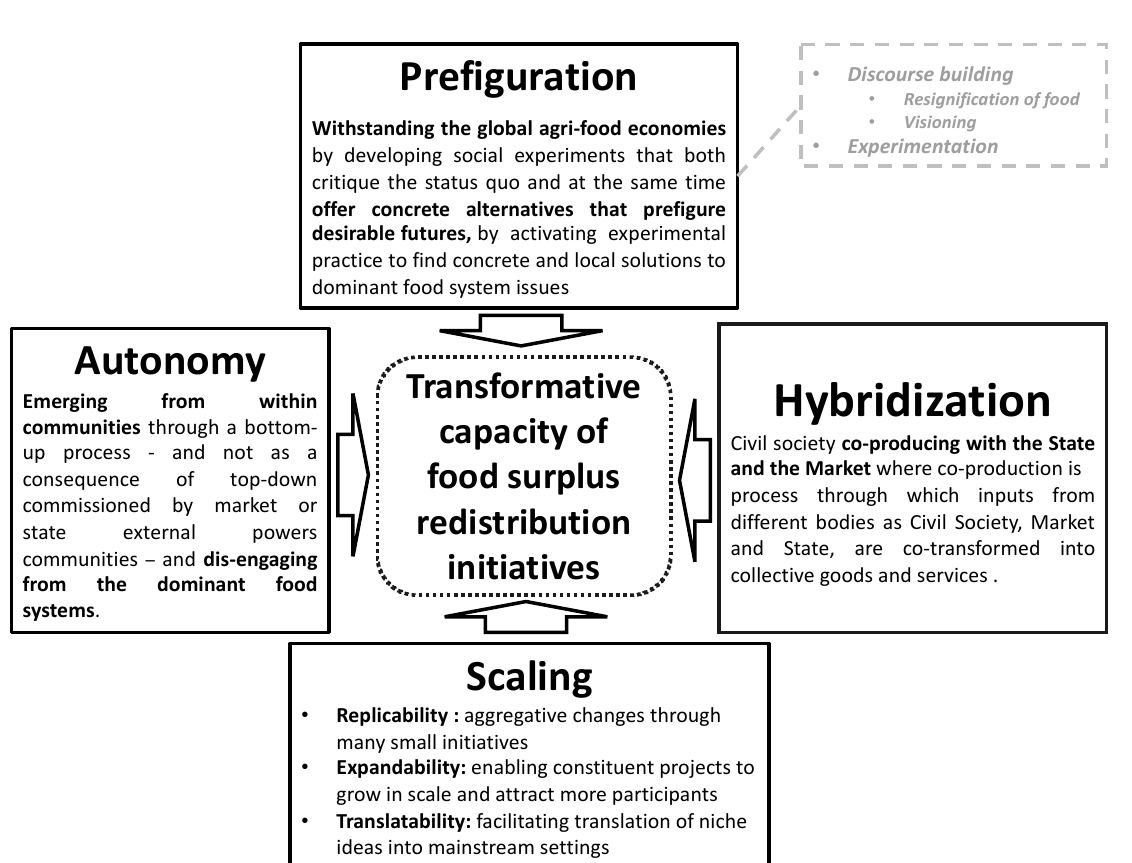
Figure 1. PAHS (prefiguration, autonomy, hybridization, and scalability) conceptual model. Prefiguration. Wilson [59] conceptualises autonomous food spaces as spaces of imagi- nation and experimentation. The combination of these two concepts represents at best the notion of prefiguration, which is considered the distinctive feature of what have been called “new social movements” [62], and particularly of the food movement [63]. The food move- ment is prefigurative because it withstands the global agri-food economies by developing social experiments that both critique the status quo and at the same time offer concrete alternatives that prefigure desirable futures. As stressed by Spring and Biddulph [57], redis- tributive initiatives can be considered transformative if they contextually contest the global food regime and they activate practice to find concrete and local solutions to food system issues; in other words, if they are prefigurative. In the case of redistributive initiatives, contestation does not refer to mass political protest along the streets, but rather in